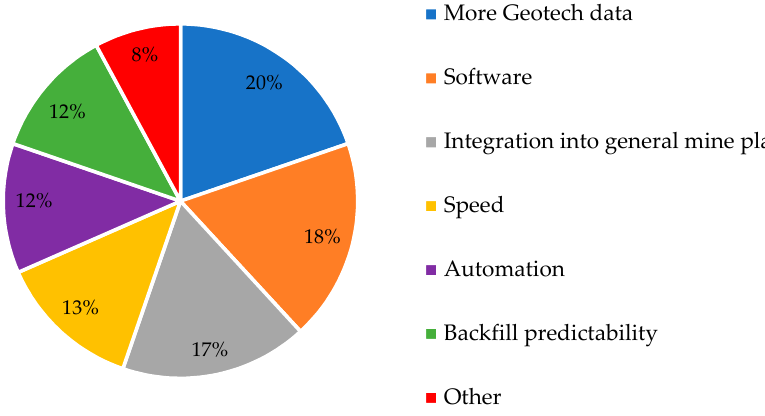
Figure 10. The application of stope performance and control after excavation takes place ( a ) includ- ing the cavity monitoring system (CMS) to measure the stopes ( b ).